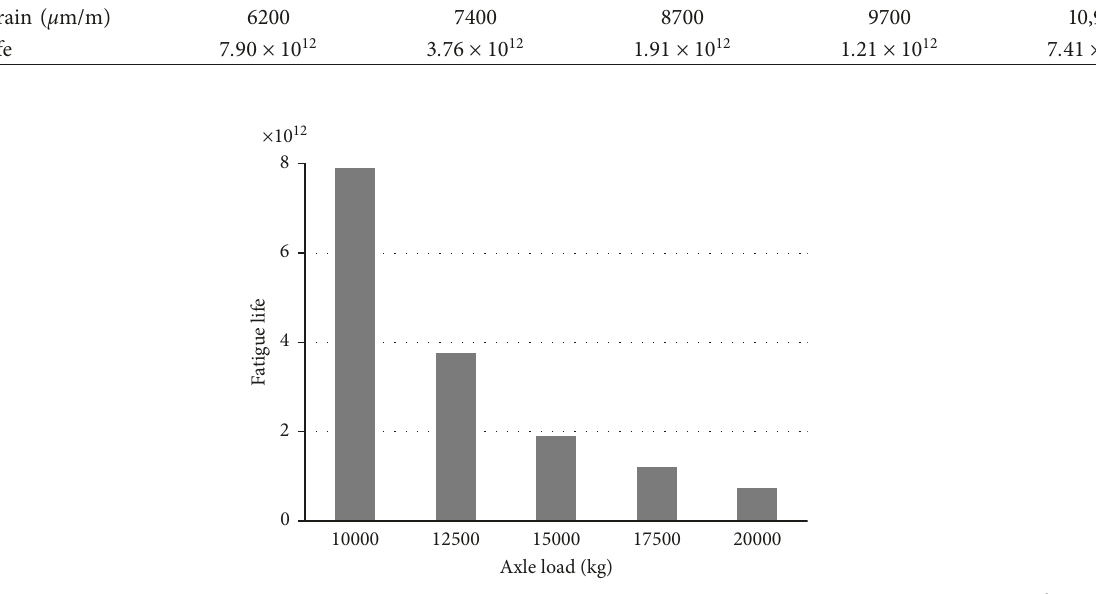
Table 9: The tensile strain and fatigue life of the asphalt pavement subjected to different axle loads after loading cycles of 1 × 10 6 . Axle load (kg)